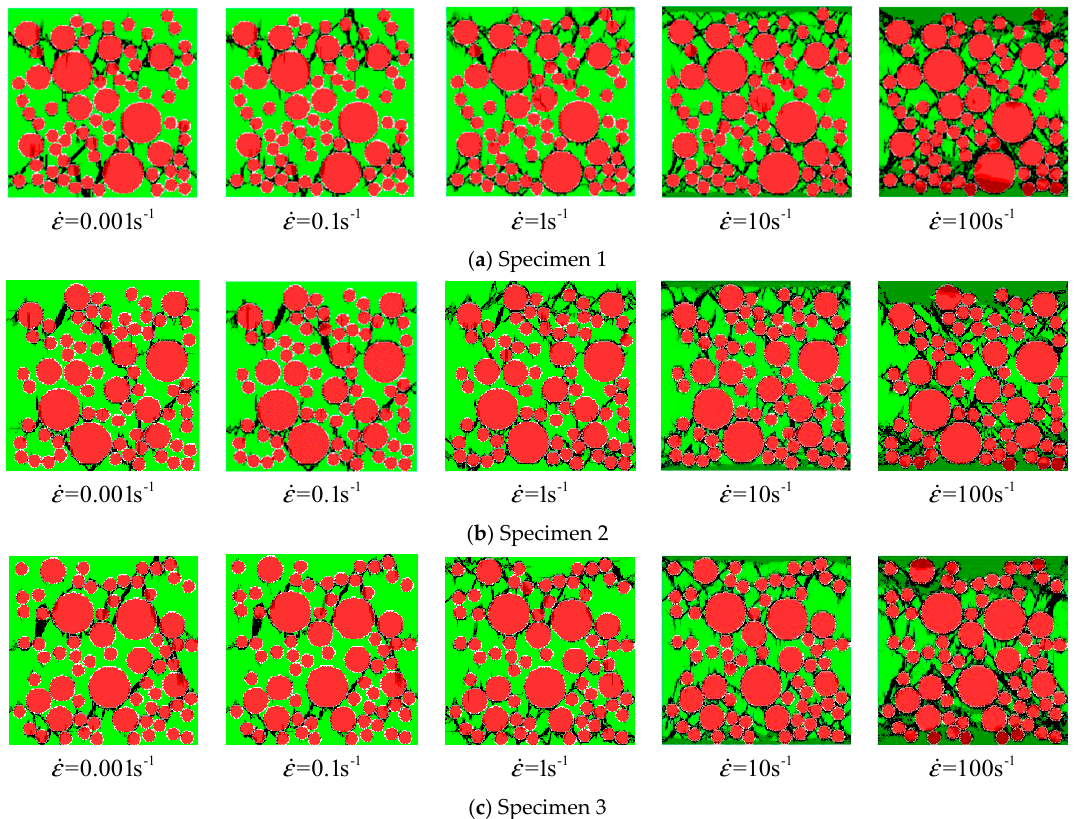
Figure 12. The failure pattern of concrete specimens under dynamic uniaxial compressive stress; ( a ) specimen 1; ( b ) specimen 2; ( c ) specimen 3.